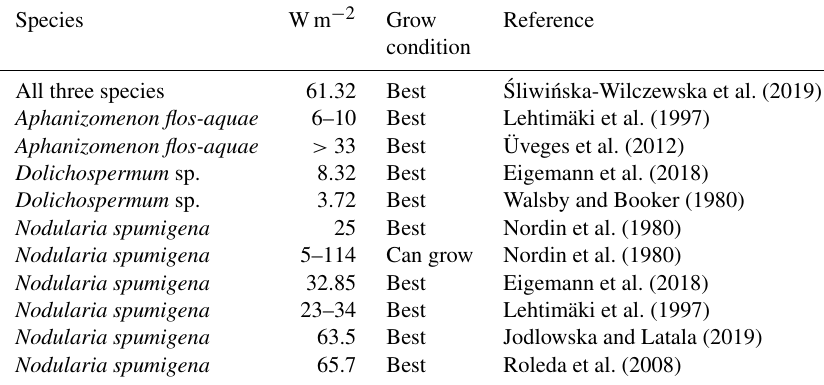
Table 9. Optimal light levels (Wm − 2 ) for the studied cyanobacteria species.